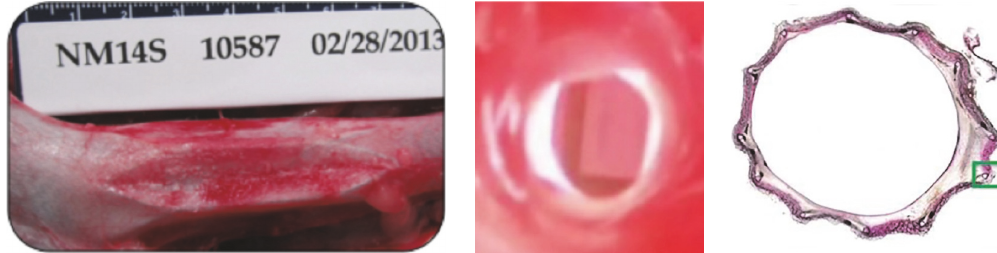
Figure 6: Representative images of IVC sections with the Sentry IVC filter (terminated at 184 days). Left: preexplant digital photograph of IVC sections with the implanted Sentry device. Middle: laparoscopic image of IVC filter within the IVC, demonstrating lumen patency. Right: transverse section stained with toluidine blue/basic fuchsin, demonstrating incorporation into the wall of the IVC. The green box indicates mild neointimal